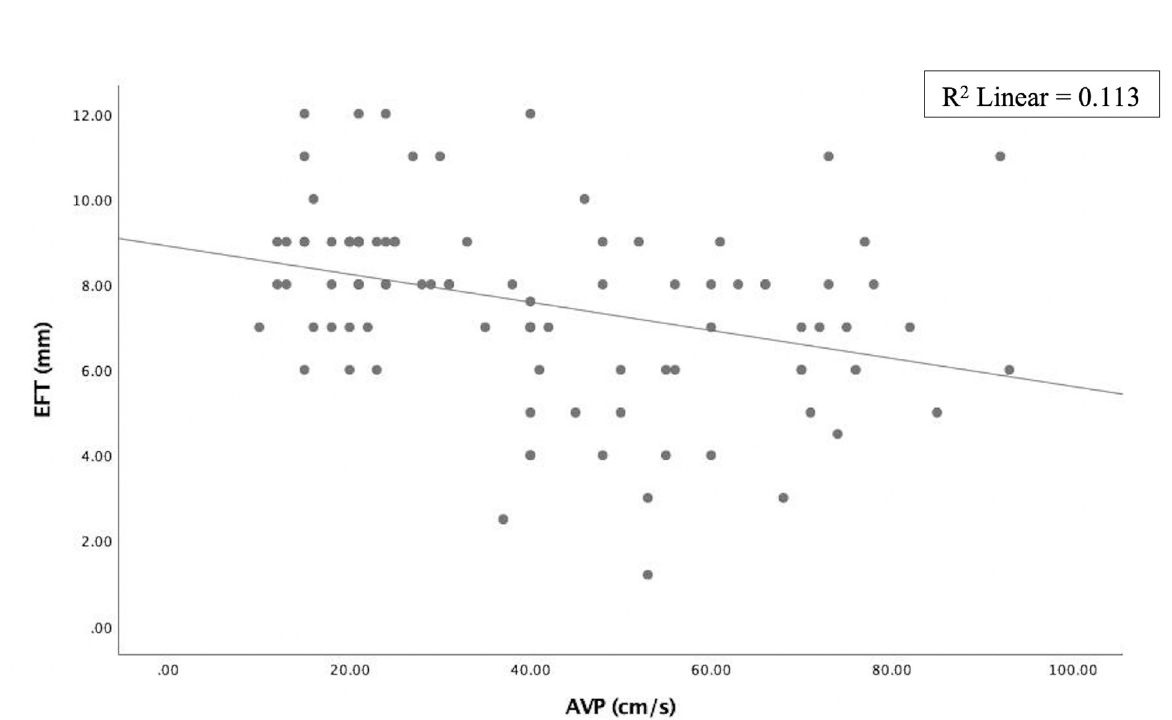
Figure 6. Correlation between Epicardial fat thickness (EFT) and Aortic velocity propagation (AVP) (r=-0.337, p=0.001, R 2 =0.114). Pearson test was used to analyze the relationship between EFT and AVP variables. Correlation coefficient (r). p<0.05 was considered statistically